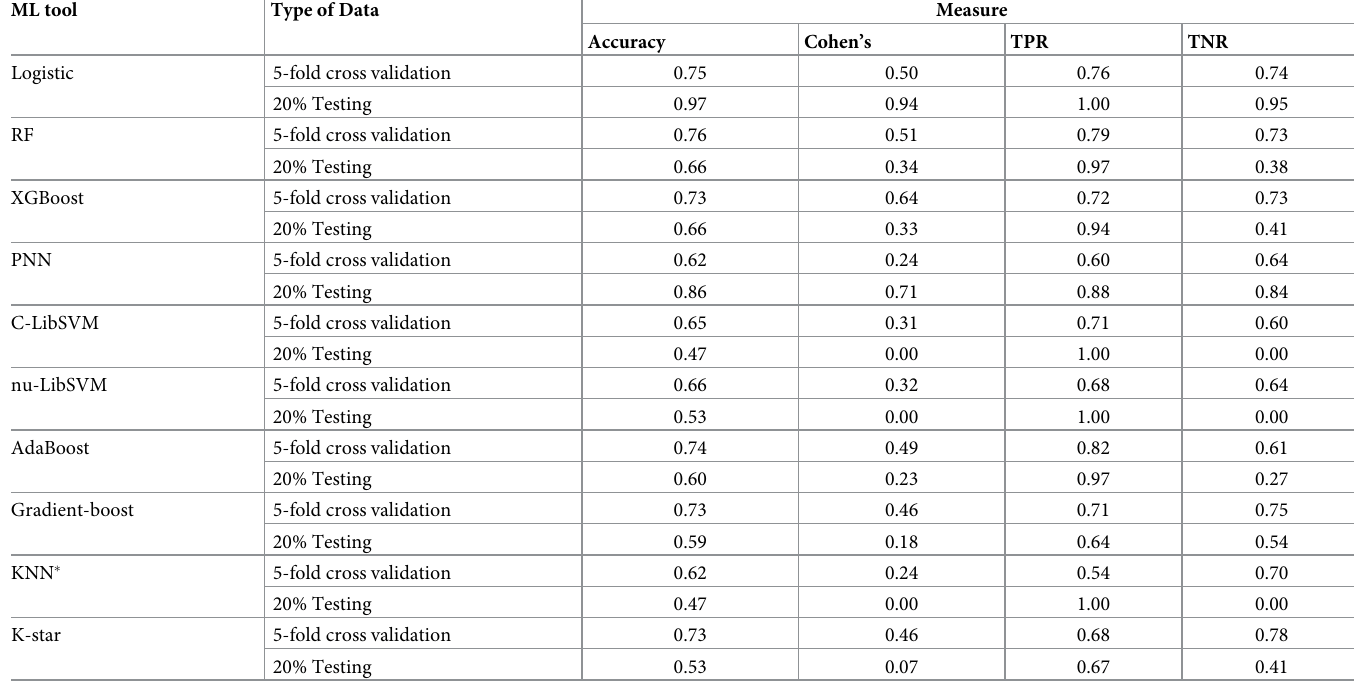
Table 9. Accuracy, cohen’s κ , TPR and TNR values based for the all ML tools and using either 5-fold cross validation or 20% testing set for prediction people with T2DM from people without T2DM. ML tool Type of